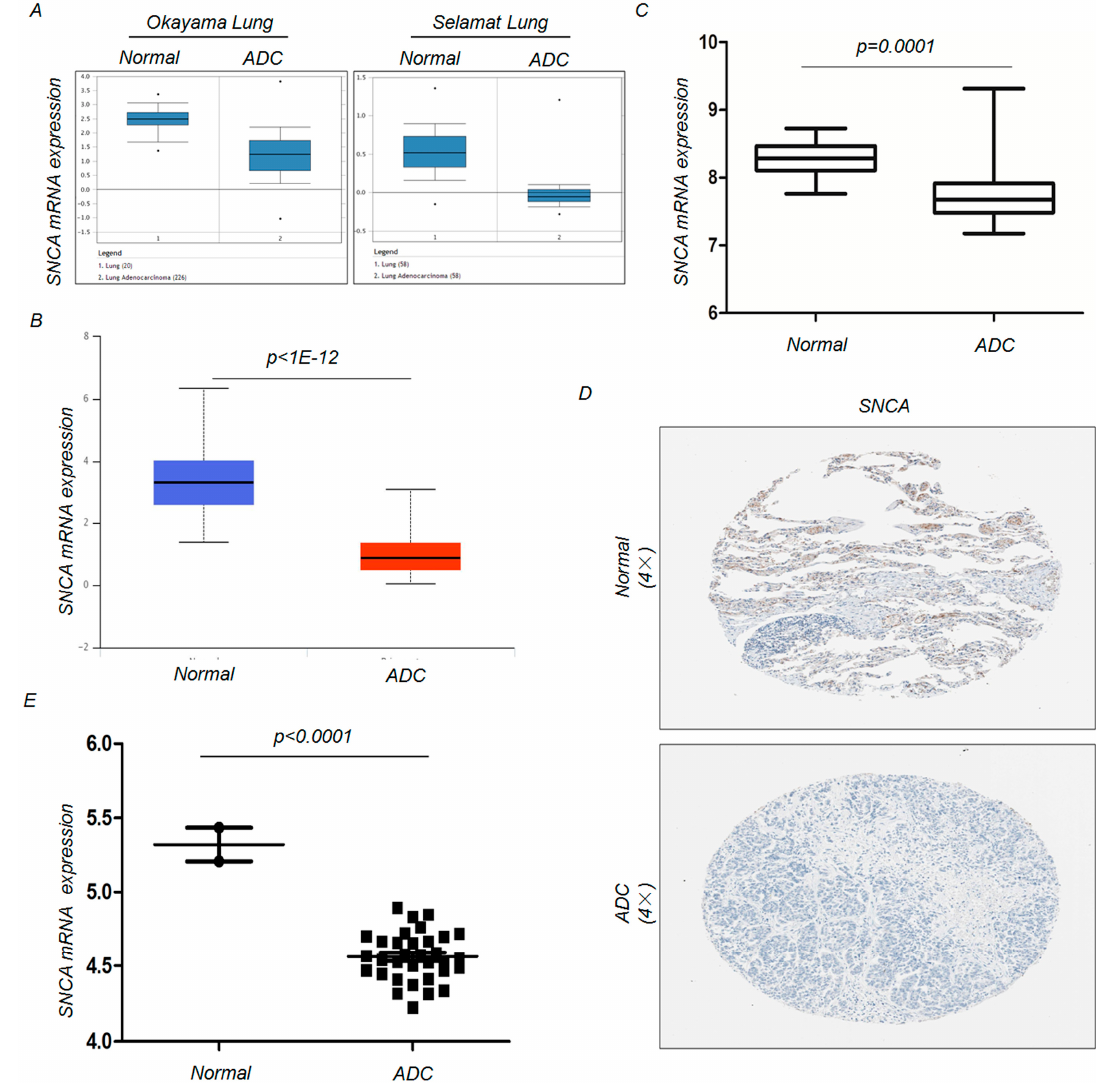
Figure 1. Analysis of SNCA expression levelsin ADC tissues and cell lines. ( A ) The messenger RNA (mRNA) expression of SNCA in Okayama Lung and Selamat Lung grouped by surrounding normal lung tissues and ADC. ( B , C ) The mRNA expression of SNCA was examined from the UALCAN and GEO public databases. ( D ) SNCA mRNA levels are significantly down-regulated in 33 LUAD cell lines, compared to 2 normal cell lines. Datawere obtained from the Cancer Cell Line Encyclopedia. ( E ) The Human Protein Atlas project shows representative immunohistochemical images from SNCA in ADC compared with noncancerous lung tissues.